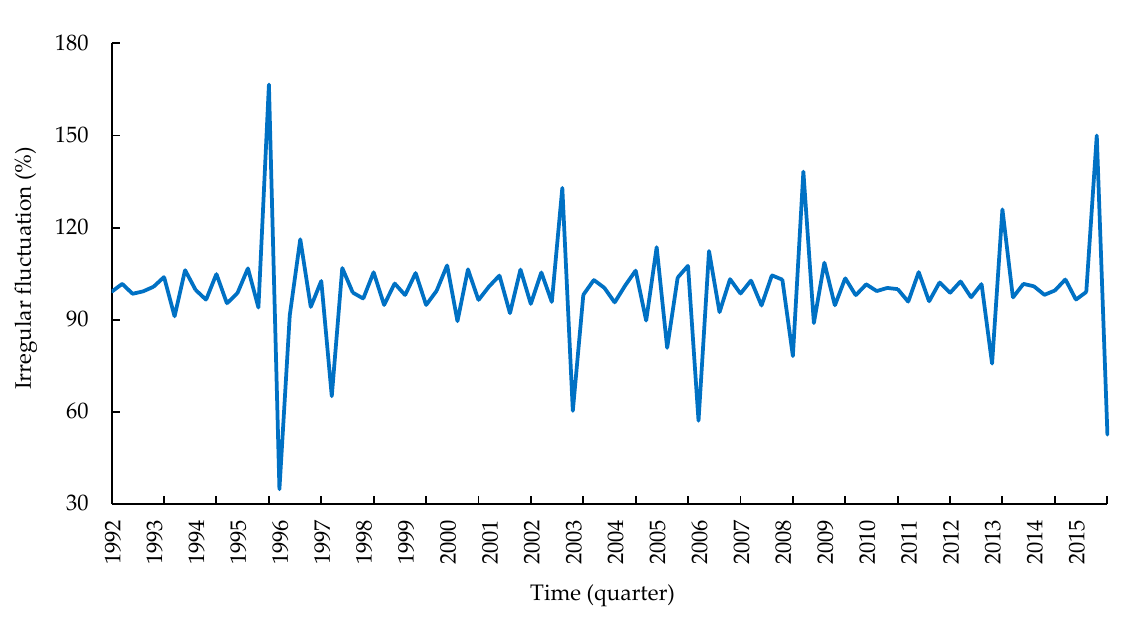
Figure 8. Decomposition of the time series of construction activities, including seasonal fluctuation indices in Hyrcanian forest in 1992–2015.